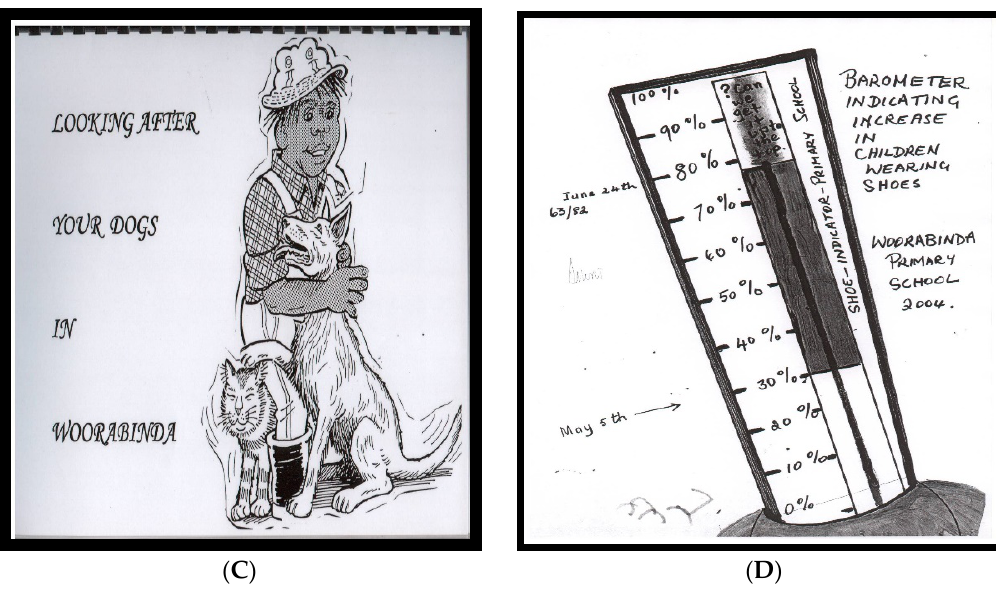
Figure 1. Health promotion material developed during the Woorabinda Strongyloides control program. ( A ) Poster on protective footwear; ( B ) Jaime and Aunty June’s comic strip described the life cycle and transmission of S. stercoralis ; ( C ) Aunty Val’s Gunna Story; ( D ) Shoe barometer.